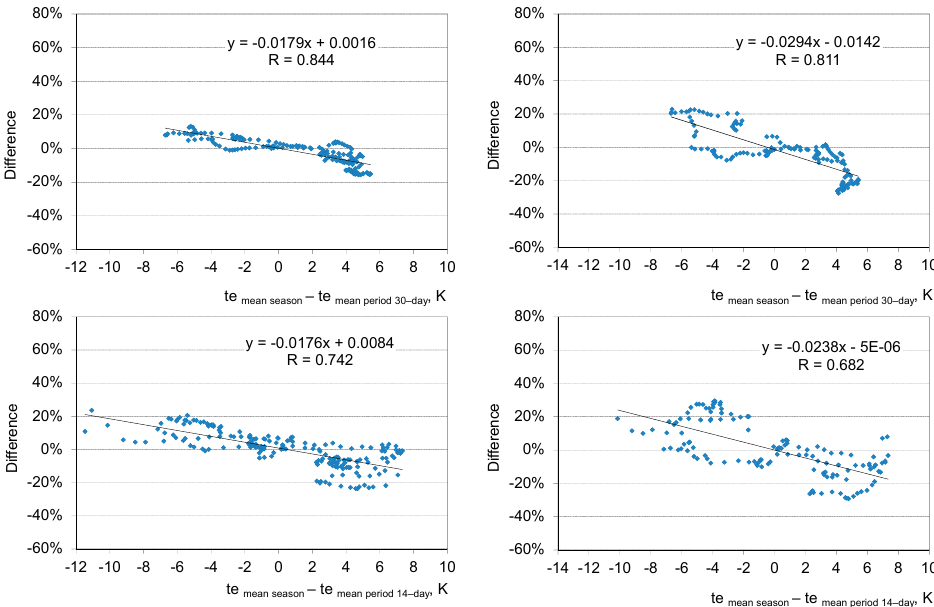
Figure 8. Correlation between the seasonal heat demand difference and external temperature difference (mean for the season and mean for each short period) for the less airtight residential building (on the left) and for the less airtight school building (on the right); only for periods with R ≥